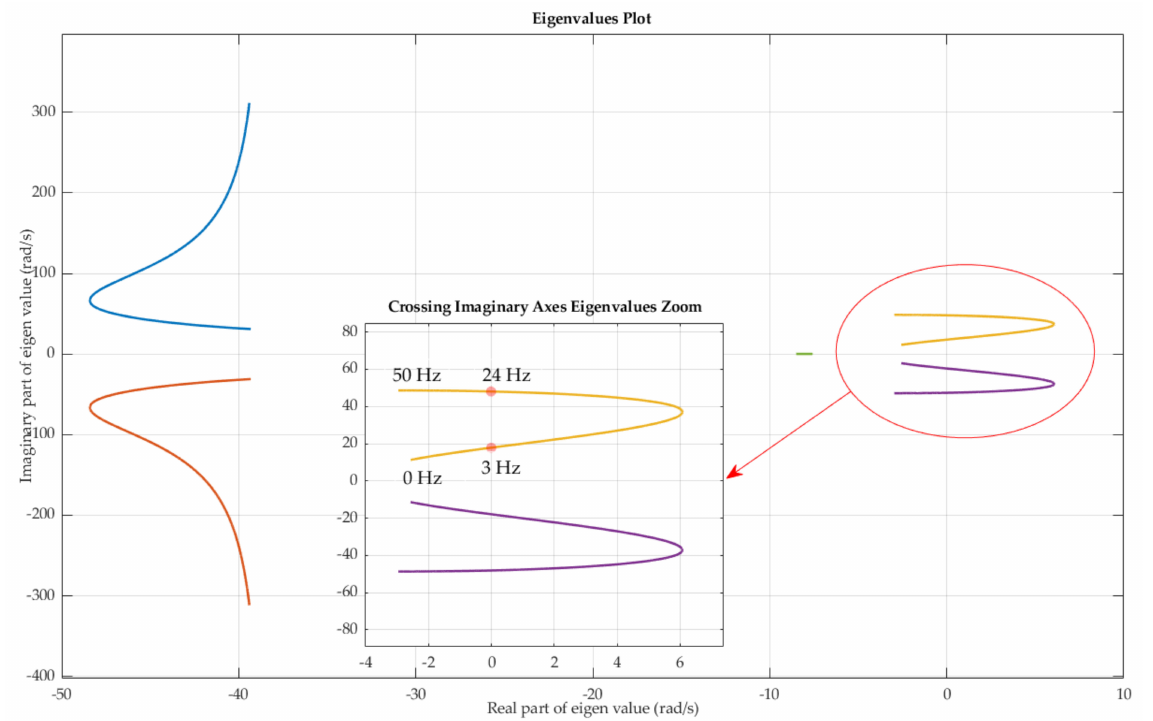
Figure 6. Locus of the eigenvalues of the 736 kW induction motor drive for a V/Hz ratio of 1 p.u. with a frequency range of 0–50 Hz, a DC bus voltage of 10.942 kV, a switching frequency of 610 Hz, and a deadtime of 7 µ